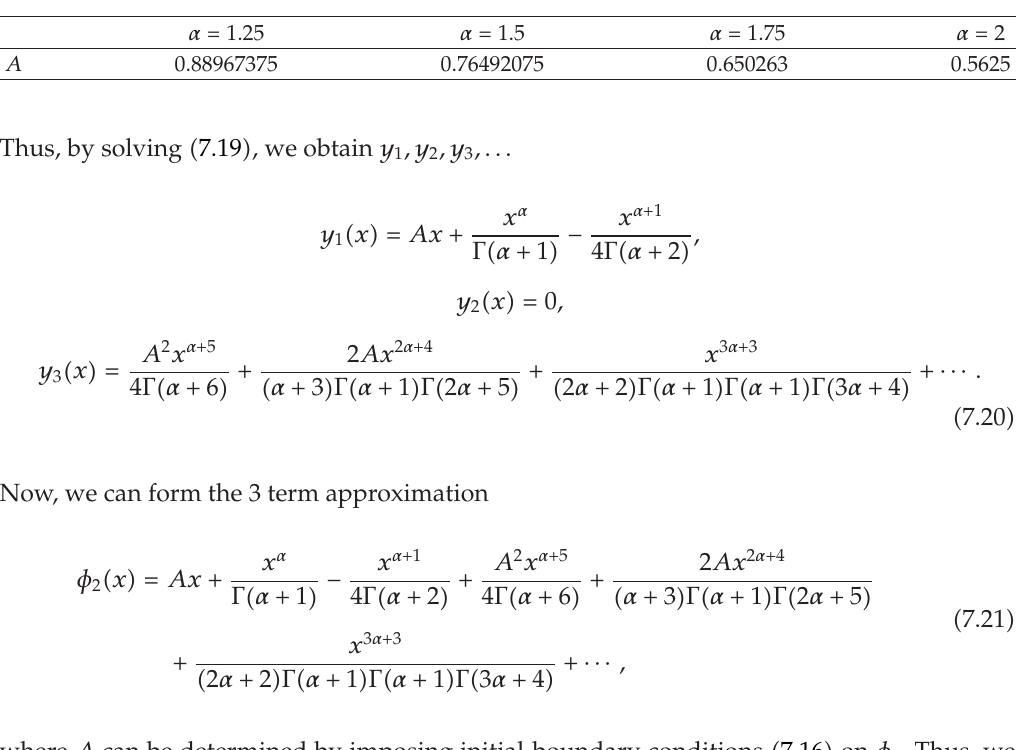
Table 4: Value of A for di ff erent values of α